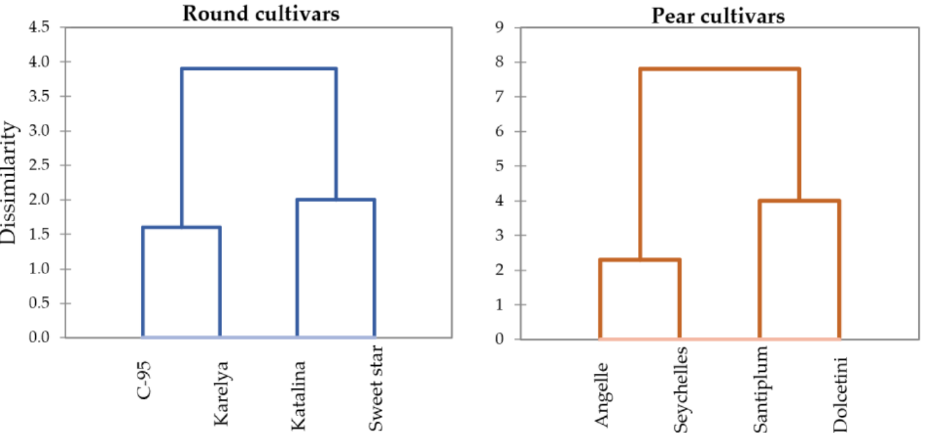
Figure 2. Dendrogram of round and pear cherry tomato cultivars.